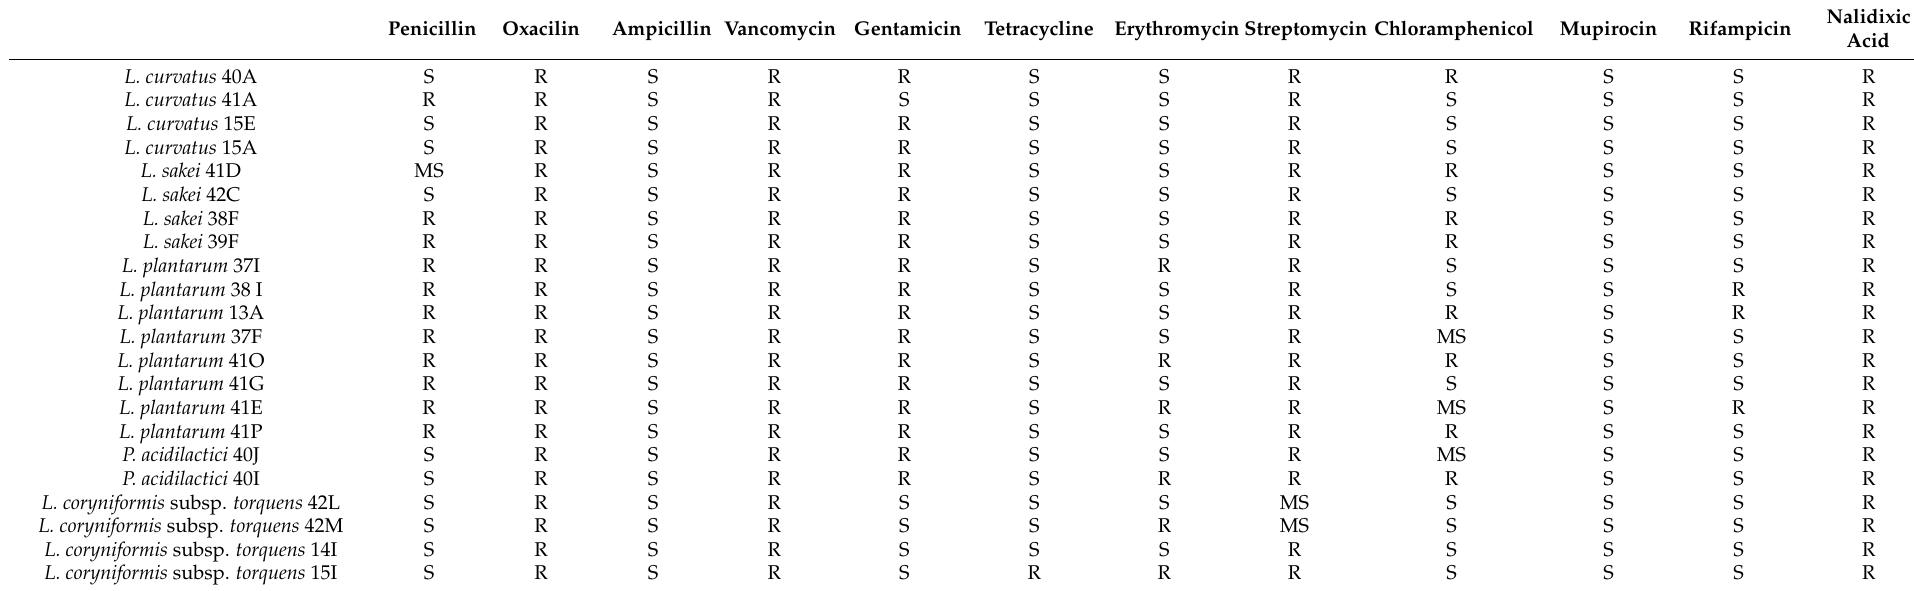
Table 3. Antibiotics susceptibility of LAB. Results were expressed as R (resistant), MS (moderately susceptible) or S